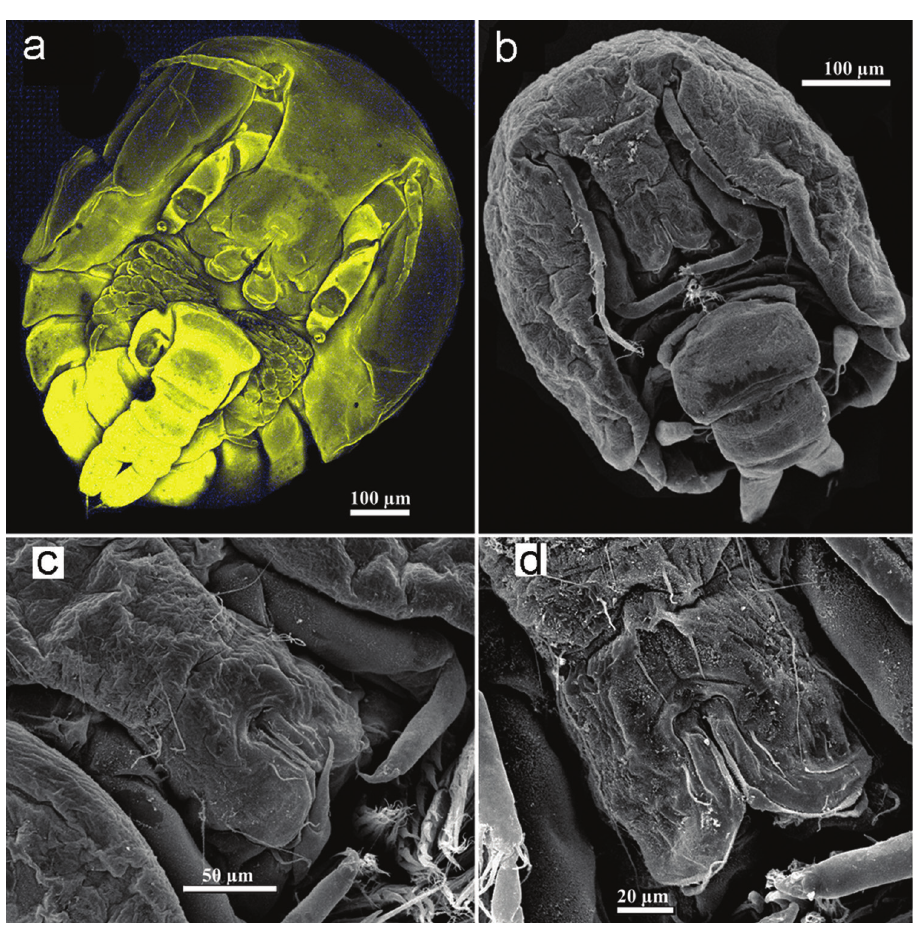
Figure 9. Spaniomolgus, females. a S. crassus (Humes & Ho, 1968), confocal photo. S. stylophorus sp. n., SEM b Habitus ventral c Rostral area d